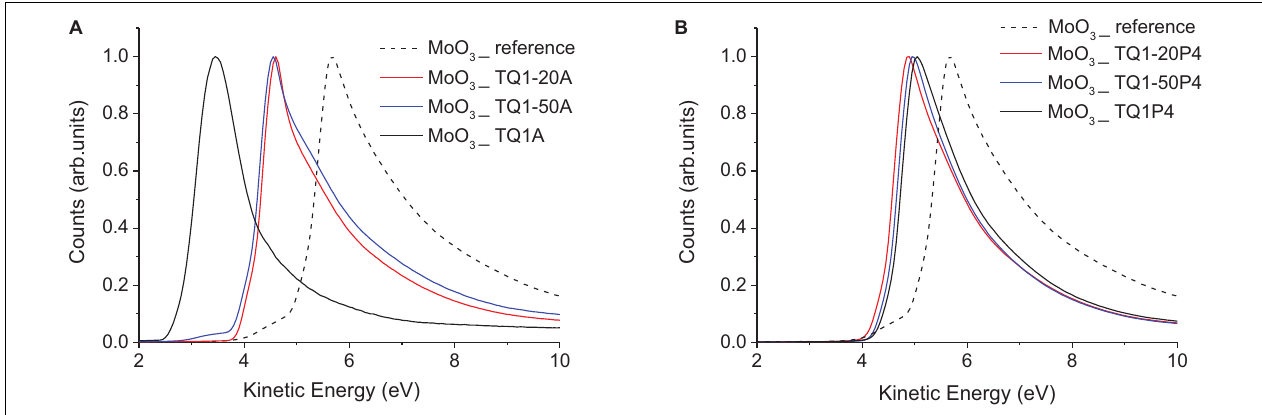
FIGURE 4 | UPS spectra of o -DCB washed MoO 3 reference and (A) thin layer of amino polymer coated MoO 3 samples, (B) thin layer of pyridine polymer coated MoO 3